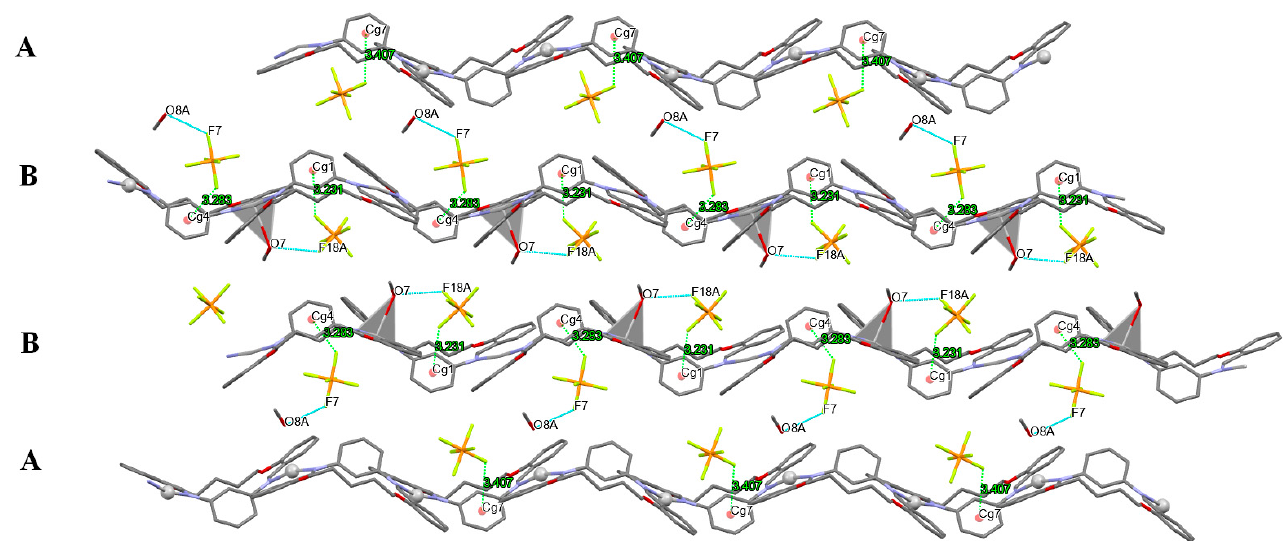
Figure 4. Representation of crystal packing in AgLPF 6 along the c axis. F ··· π interactions between PF 6 anion and benzene rings are represented by green dashed lines. O–H ··· F interactions between MeOH molecules (coordinated and uncoordinated) and discrete polymeric chains are represented by blue dashed lines. The view is down the b axis.